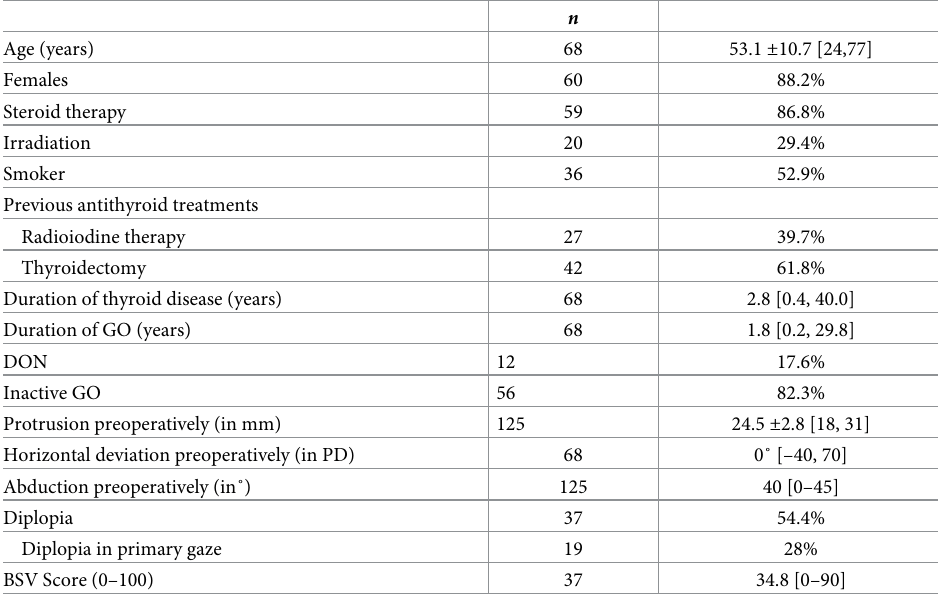
Table 1. Baseline characteristics of study population.